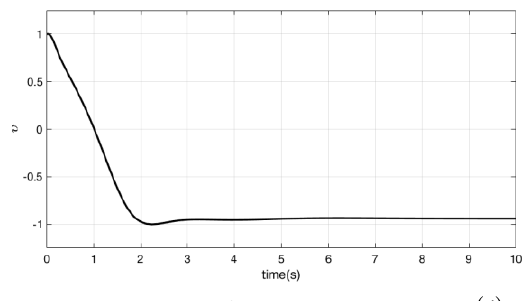
Figure 4. The change of time-varying parameter   t  .